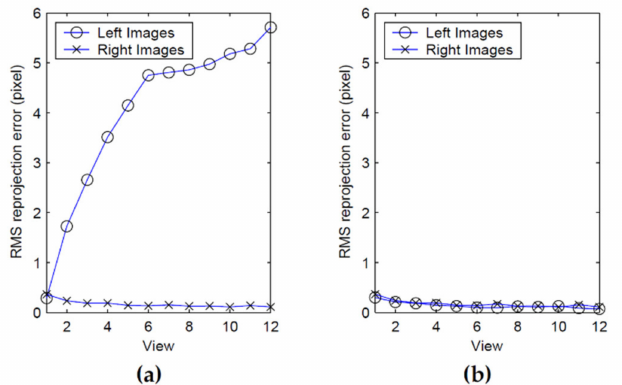
Figure 9. RMS reprojection error before ( a ) and after ( b ) the application of the calibration procedure for E CrCl as a function of the image number index. This result shows that the reprojection error is small and, more importantly, is the same for the left and right images.